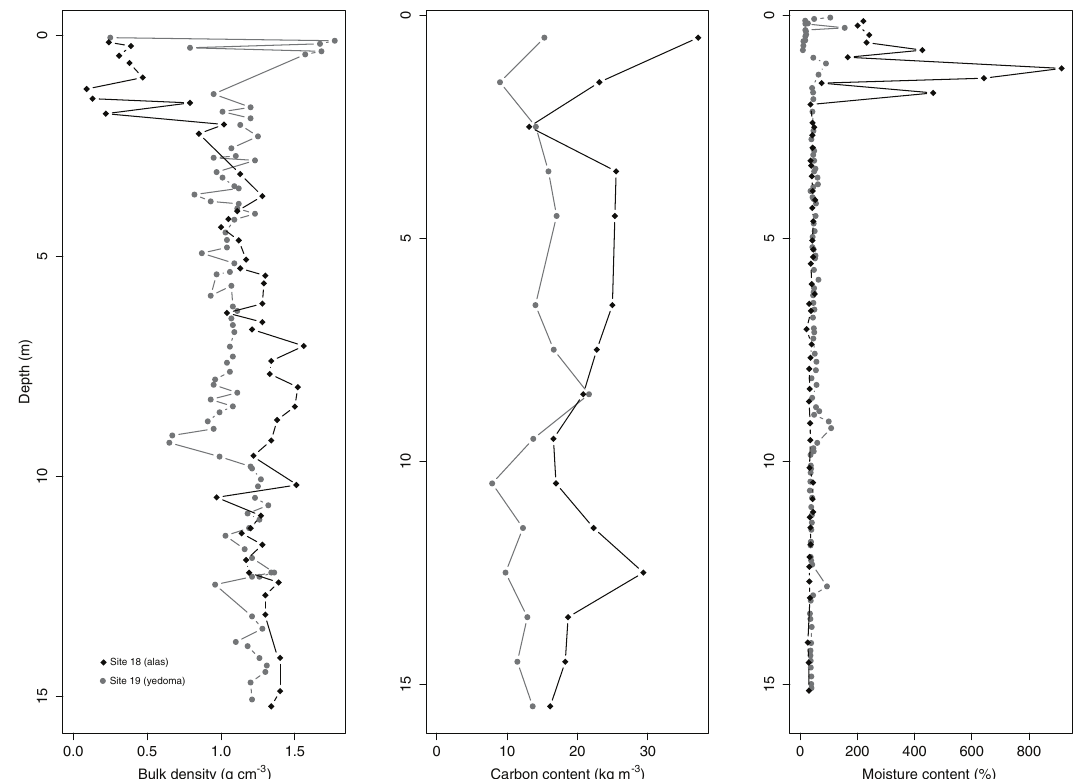
Figure 5. Bulk density, carbon density, and ice content of the two deep (15m) permafrost soil